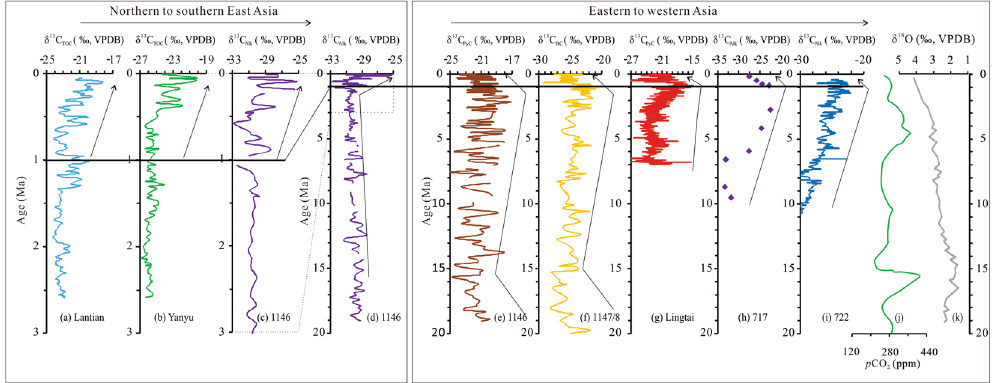
Figure 3. Summary of data for ODP core 1146 compared with similar data from sites proximate to, and on, the continent of Asia. Charts in the left panel summarise data north to south across East Asia. ( a ) and ( b ) δ 13 C TOC from transect sections on Chinese Loess Plateau (from northwest to southeast: Lantian, Yanyu) 12, 18 ; ( c ) and ( d ) δ 13 C alk values from core 1146 since the last 3 Ma and since about 19 Ma (this study). The right panel summarises data from a far larger area. ( e ) δ 13 C values of PyC from core 1146 in this study; ( f ) and ( g ) δ 13 C values of black carbon from 1147/8 and δ 13 C values of PyC from Lingtai loess section 16, 37 ; ( h ) and ( i ) marine sediments in Indian Ocean (ODP 717) 62 and Bengal Fan (ODP 722) 63 ; ( j ) Published p CO 2 records since the mid-Miocene based on a compilation of CO 2 curves (green line) 59 ; ( k ) Simplified composite δ 18 O record of deep-sea benthic foraminifera as a proxy for global temperature variations 65 . Dashed line shows in enlarged form the record for δ 13 C δ 13 C values occurring since the alk in core 1146 since the last ~3 Ma. Solid line highlights the divergence of mid Quaternary. Arrows show direction of overall change in the